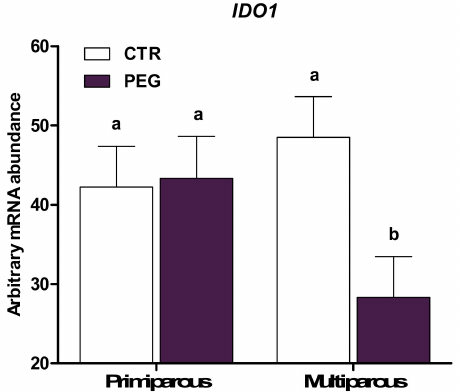
Figure 5. LSM ± SEM of Log10 arbitrary mRNA abundance for gene expression of IDO1 (indoleamine 2,3-dioxygenase 1) evaluated three days after calving in primiparous and multiparous cows treated either with pegbovigrastim (PEG) or with saline (CTR) at approximately Day 7 relative to calving and on the day of calving within 24 h. Di ff erent letters represent significant di ff erences among groups at p ≤